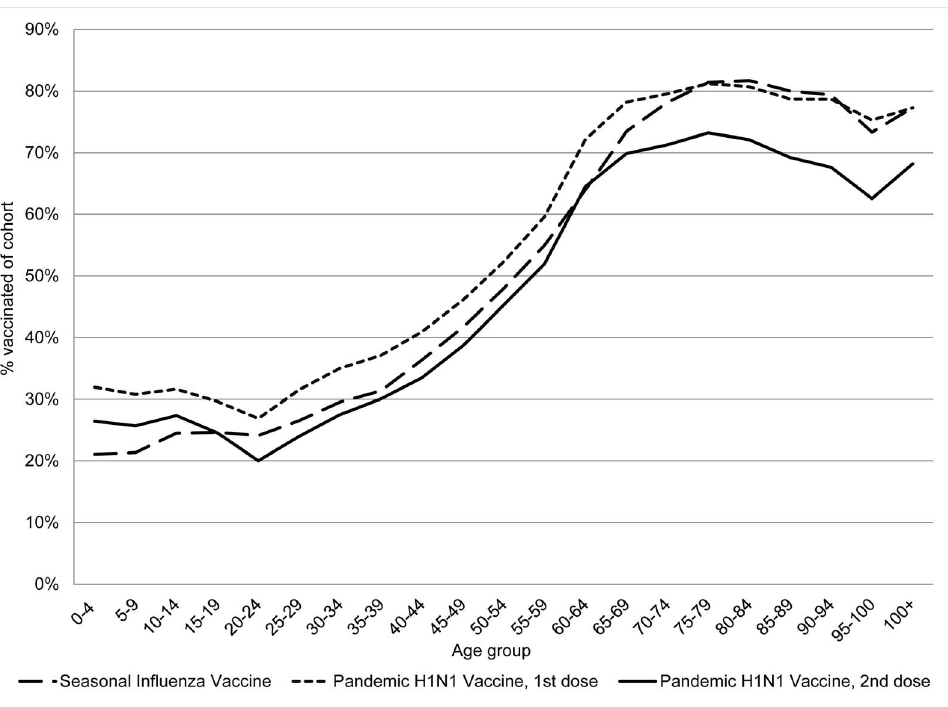
Figure 1. Vaccination coverage per age group. Vaccination coverage per age group for seasonal influenza vaccination and first and second doses of influenza A(H1N1)pdm09 vaccine in the cohort of patients that had an indication for pandemic influenza vaccination.